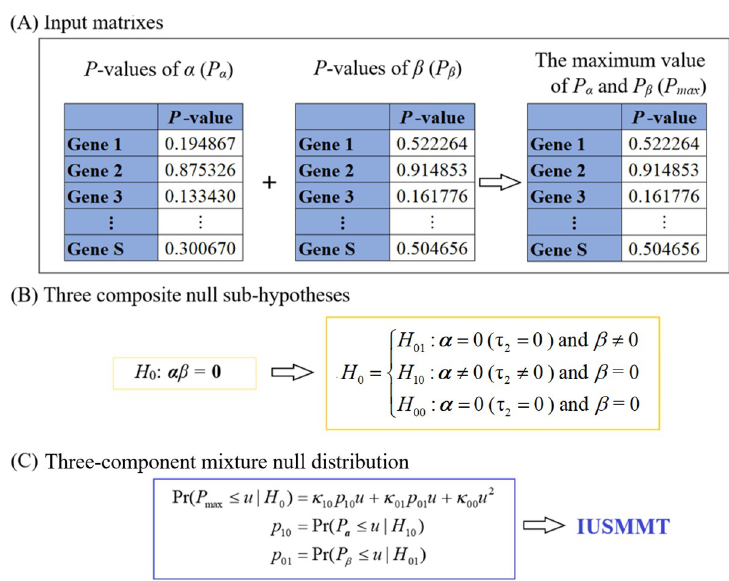
Fig 2. An overview of IUSMMT for examining the mediation effect in survival model. Here, a = ( α 1 , ... , α K ) is the vector of effect sizes of a set of DNA methylation CpG sites (i.e., the exposures) on the gene expression level (i.e., the mediator), with K the number of CpG sites within that gene; and β is the expression-survival effect; S indicates the total number of genes; n denotes the sample size. (A) IUSMMT first separately evaluates the significance of a and β , and calculates P α and P β ; where P α is obtained by a variance component-based score test within the linear mixed-effects model by assuming each of a following a mean-zero normal distribution with an unknown variance τ 2 , while P β is yielded through the Wald test within the Cox linear mixed-effects model. Then, IUSMMT takes the two P -values as input. (B) The hypothesis testing of mediation effect is to examine whether the product of α and β is zero or not (i.e., H 0 : α β = 0 ) and can be divided into three composite null sub-hypotheses. (C) In the three-component mixture null distribution, κ 10 stands for the probability that the exposures are related to the mediator in the exposure-mediator model but the mediator is not associated with the survival outcome in the mediator-outcome model; κ 01 stands for the probability that the exposures are not related to the mediator in the exposure-mediator model but the mediator is associated with the survival outcome in the mediator-outcome model; κ 00 stands for the probability that the exposures are not related to the mediator in the exposure-mediator model and the mediator is not associated with the survival outcome in the mediator-outcome model. The definition of other notations used in B and C can be found in the Materials and Methods